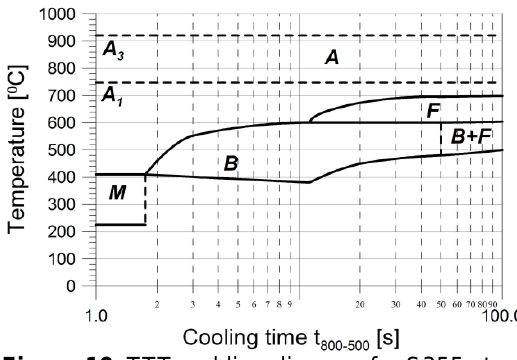
Figure 10. TTT-welding diagram for S355 steel